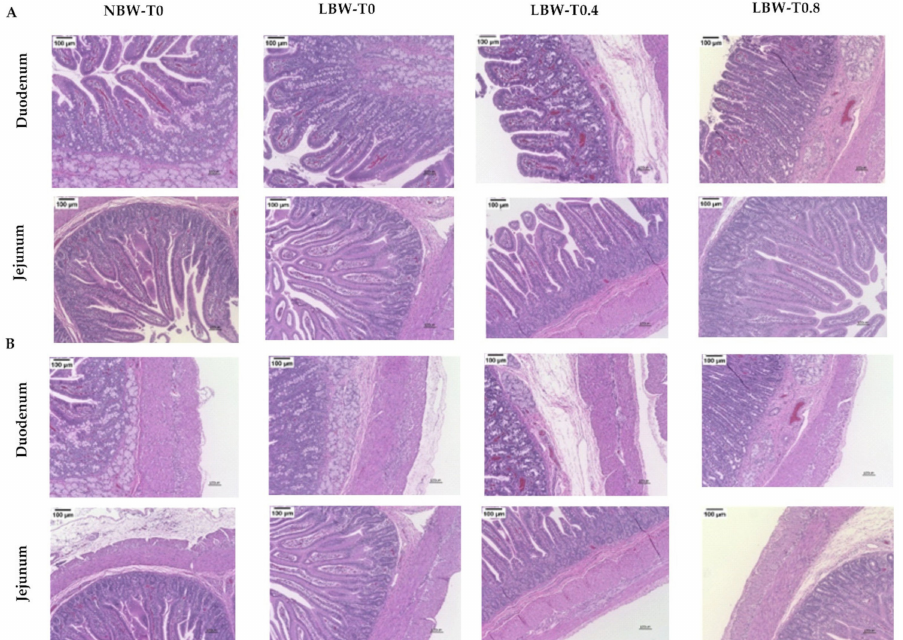
Figure 3. Effect of dietary L-tryptophan supplementation on the morphology and development of the duodenum and jejunum in low-birthweight neonatal pigs. Representative hematoxylin and eosin- stained sections ( × 10 magnification) micrograph of the duodenum and jejunum for ( A ) villi and ( B ) muscle. NBW-T0, normal-birthweight piglets fed a basal diet without supplemented L-tryptophan (Trp); LBW-T0, low-birthweight piglets fed a basal diet without supplemented Trp; LBW-T0.4, low- birthweight piglets fed a diet supplemented with 0.4% Trp; and LBW-T0.8, low-birthweight piglets fed a diet supplemented with 0.8%